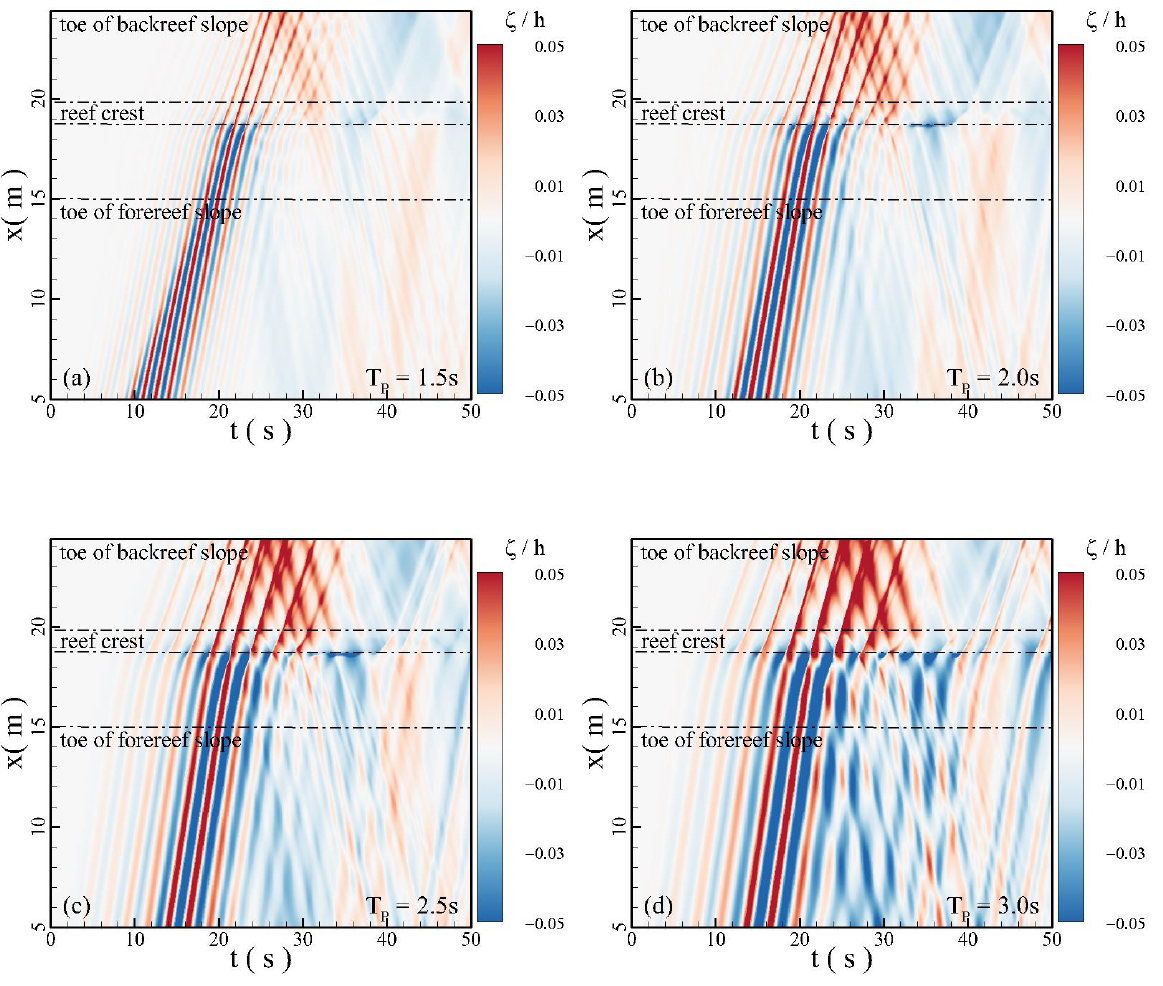
Figure 25. Spatial – temporal evolutions of the water elevation along the simulation zone; ( a ) 𝑇 𝑝 =1.5 s; ( b ) 𝑇 𝑝 =2.0 s; ( c ) 𝑇 𝑝 =2.5 s; ( d ) 𝑇 𝑝 =3.0 s.